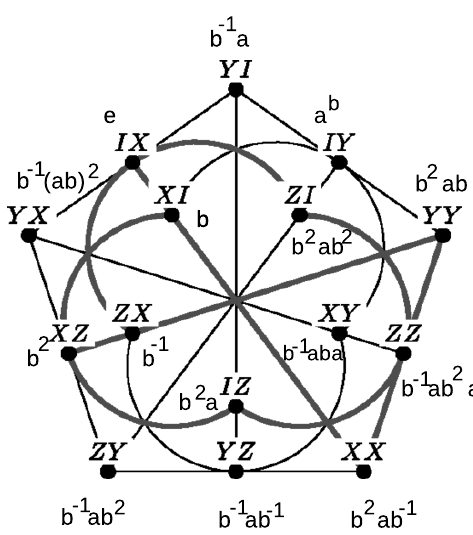
Figure 1. The generalized quadrangle of order two GQ ( 2,2 ) . The picture provides a representation of the fifteen 2 QB observables that are commuting by triples: the lines of the geometry. Bold lines are for an embedded 3 3 grid (also called Mermin square), that is, a basic model of Kochen–Specker theorem × (e.g., see ([3], Figure 1) or [10]). The second representation is in terms of the cosets of the permutation group arising from the index 15 subgroup of G ∼ = A 6 (the 6-letter alternating group).